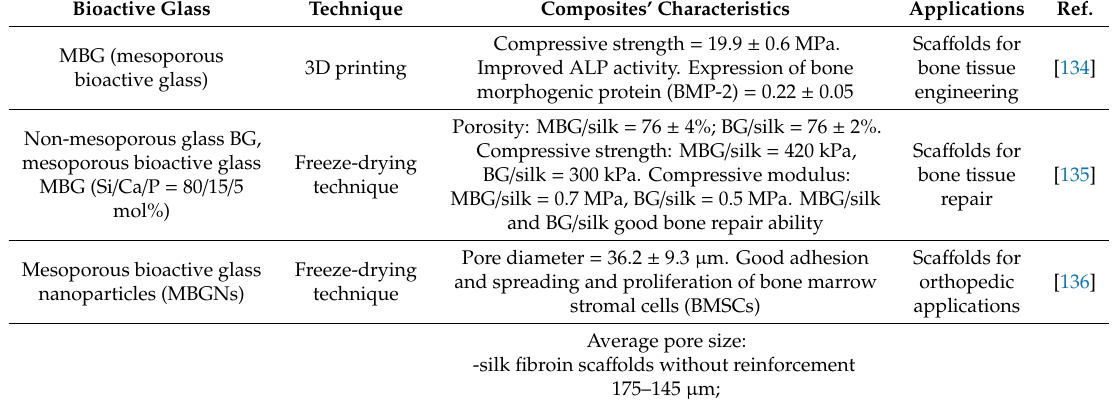
Table 3. Summary of silk fibroin / bioactive glass composites for various biomedical